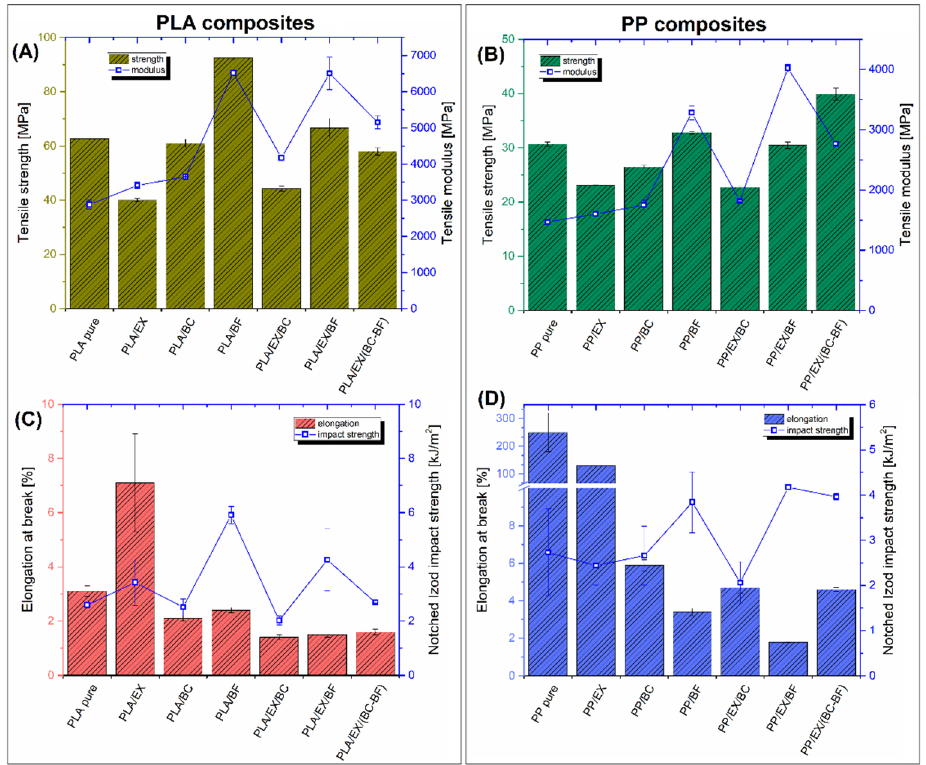
Figure 7. The results of the static tensile and Izod impact resistance tests. The tensile strength and modulus of ( A ) PLA-based and ( B ) PP-based composites. Elongation at break and impact strength, respectively, of ( C ) PLA and ( D ) PP-based materials.